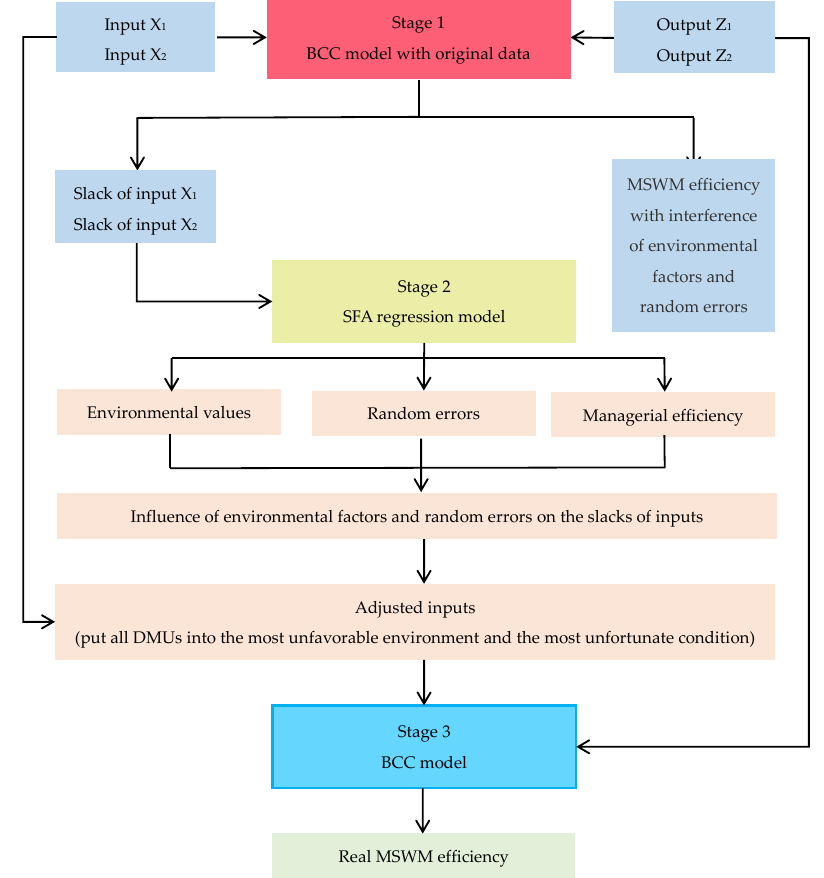
Figure 1. Figure 1. The framework of the established three-stage data envelopment analysis (DEA)